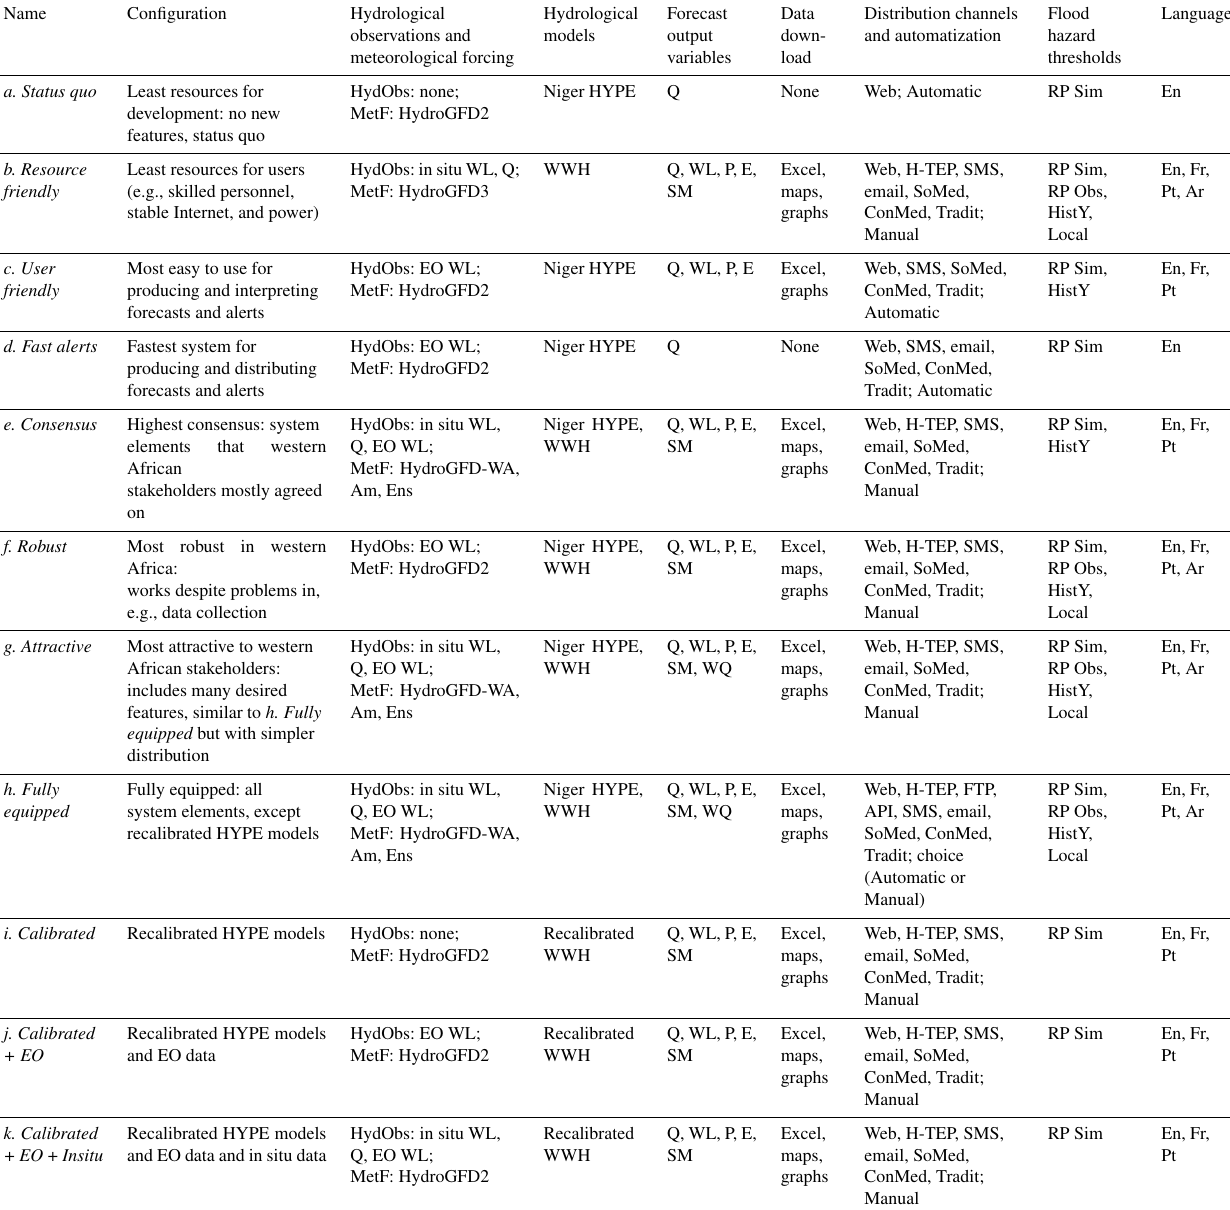
Table 2. Overview of 11 FEWS configurations. Selected main characteristics: recent hydrological observation data types (HydObs; WL: water level, Q: river discharge, EOs: earth observations) and meteorological input/forcing data (MetF; HydroGFD; HydroGFD3 – Berg et al., 2021, improved version; HydroGFD-WA: HydroGFD2 adjusted by western African meteorological observations; Am: American meteorological forecasts (e.g., GFS); Ens: ECMWF ensemble meteorological forecasts); hydrological models (WWH: World-Wide